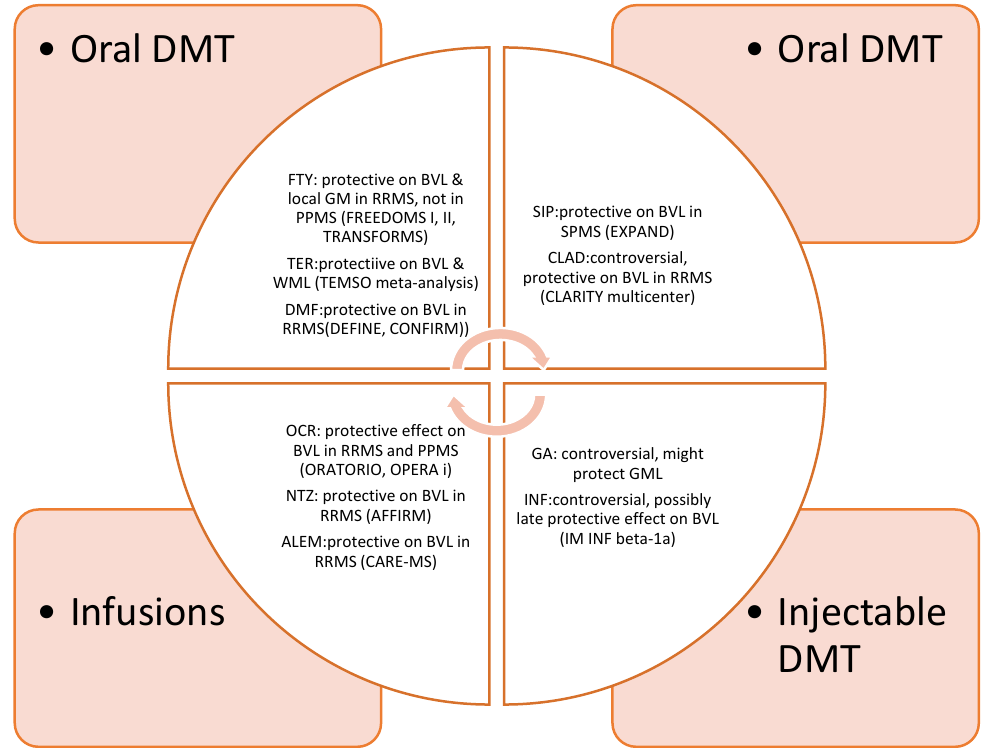
Figure 1. Effect of FDA-_approved DMT on brain atrophy. DMT: Disease modifying treatment. FTY: Fingolimod, TER: Teriflunomide, DMF: Dimethylfumarate, SIP: Siponimod, CLAD: Cladribine, GA: Glatiramer acetate, INF: Interferons, OCR: Ocrelizumab, NTZ: Natalizumab, ALEM: Alemtuzumab, WML: white matter loss, GML: gray matter loss, BVL: brain volume loss.